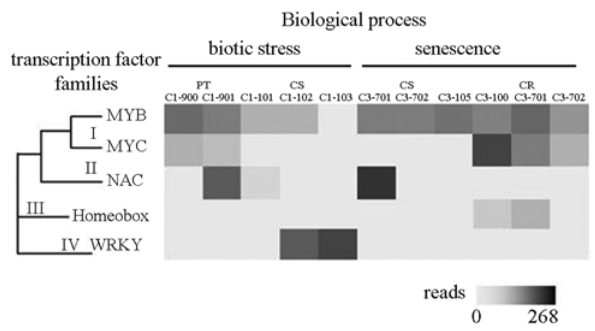
Figure 4 - Differential expression of JA-induced transcription factors in citrus.Thenormalizednumberoftranscriptionfactorhomologousreadsin each library is represented as grayscale. Citrus species libraries are repre- sented by two-word abbreviations (CS, C. sinensis ; CR, C. reticulata ; CL, C. limonia ; CG, C. aurantifolia ; CA, Citrus aurantium; LT, C. latifólia; PT, Poncirus trifoliata ). Hierarchical clustering of the expression patterns is represented by Roman